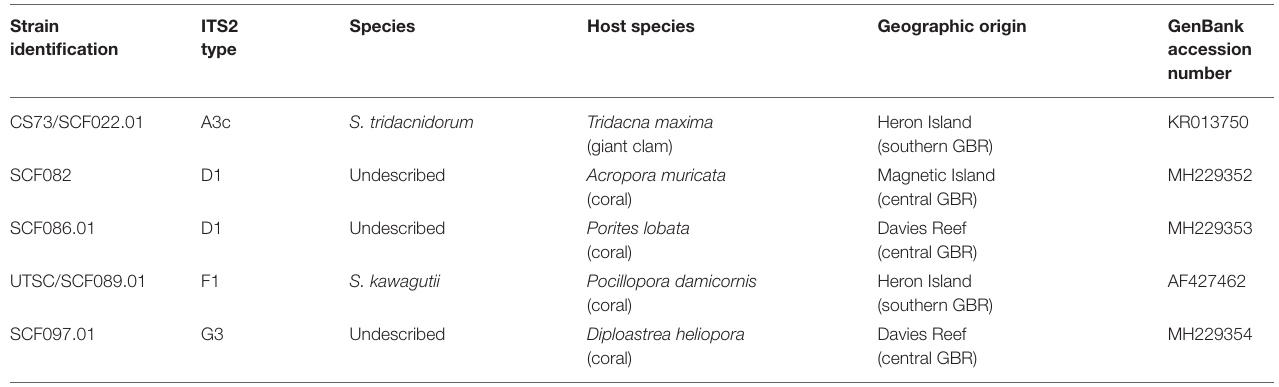
TABLE 1 | Symbiont species, type (ITS2), host species and site of origin for each Symbiodinium strain used in this study. Strain